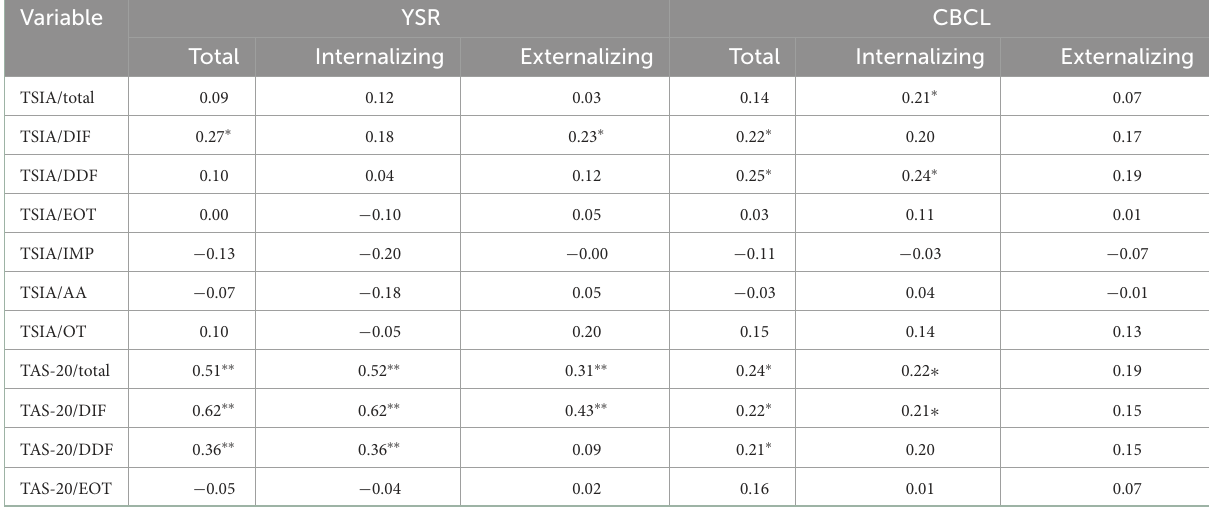
TABLE 4 Correlations between the alexithymia scores in the Toronto Structured Interview for Alexithymia a , the Toronto Alexithymia Scale 20 items b and the emotional-behavioral problems c in 95 community adolescents. Variable YSR CBCL Total Internalizing Externalizing Total Internalizing